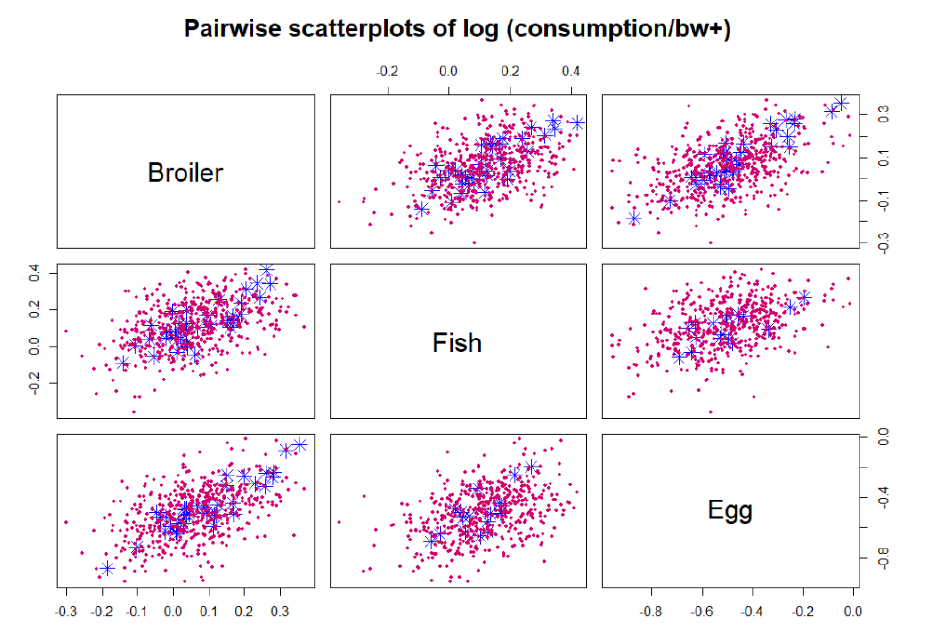
Figure 6. Example of pairwise correlations between log-consumption amounts on actual consumption days. Data points in blue and model simulated points in magenta (dots). Similar scatter plot is also available for mean log-consumption. Numerical values depend on the measurement units used in the user’s data, e.g., logarithm of kg or g per body